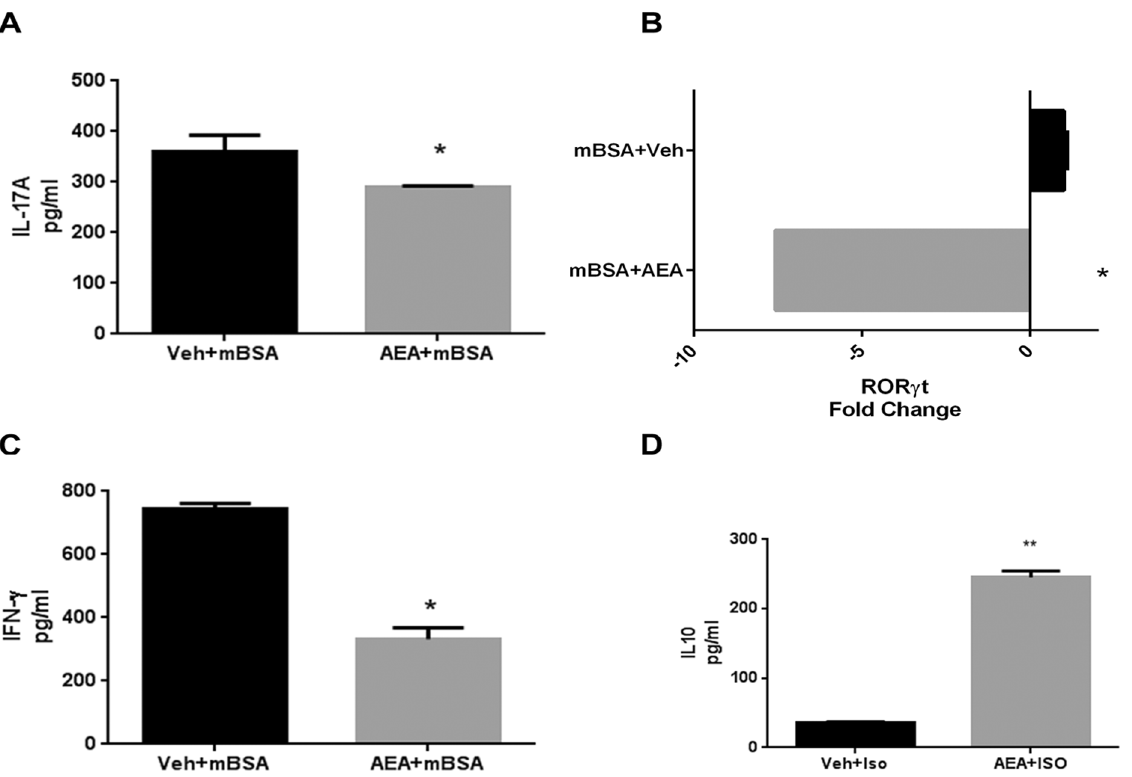
Figure 3. AEA treatment induces IL-10 expression, while suppressing IL-17 and IFN- c . DTH response against mBSA was induced as described in Fig 1. Cells from draining lymph nodes of mBSA-rechallenged mice were isolated and cultured overnight to allow for spontaneous cytokine secretion. The culture supernatants were then analyzed for IL-17 [A], IFN- c [C], and IL-10 [D]. ELISA data are representative of 3 individual experiments with n=3. [B] RNA was isolated from LN of mice treated with AEA or Vehicle to analyze the expression of ROR c t by RT-PCR. PCR plot is representative of 3 individual experiments with n=3. *p , 0.05 **p , 0.01 when compared to vehicle.